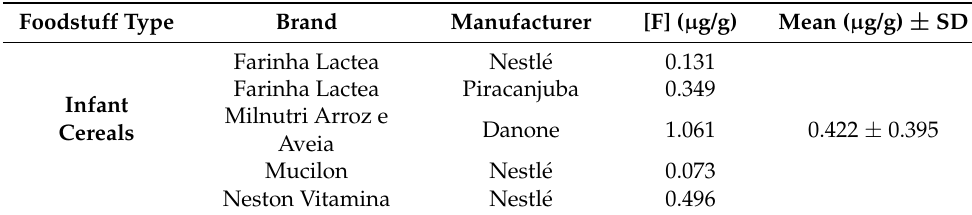
Table 2. Mean fluoride content of the different types of infant cereals that were analyzed.